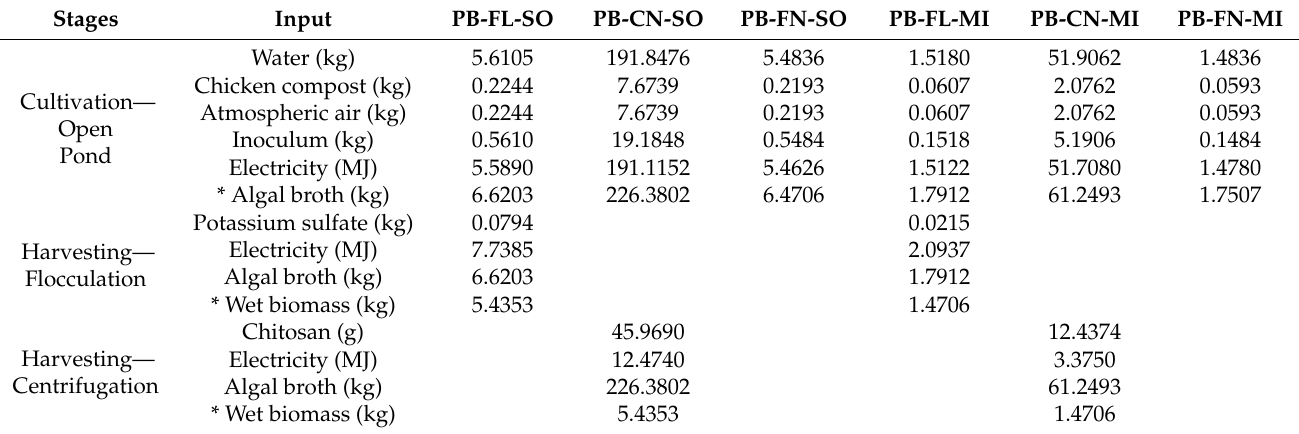
Table A5. Life cycle inventory for 1 kg of biodiesel (photobioreactor)